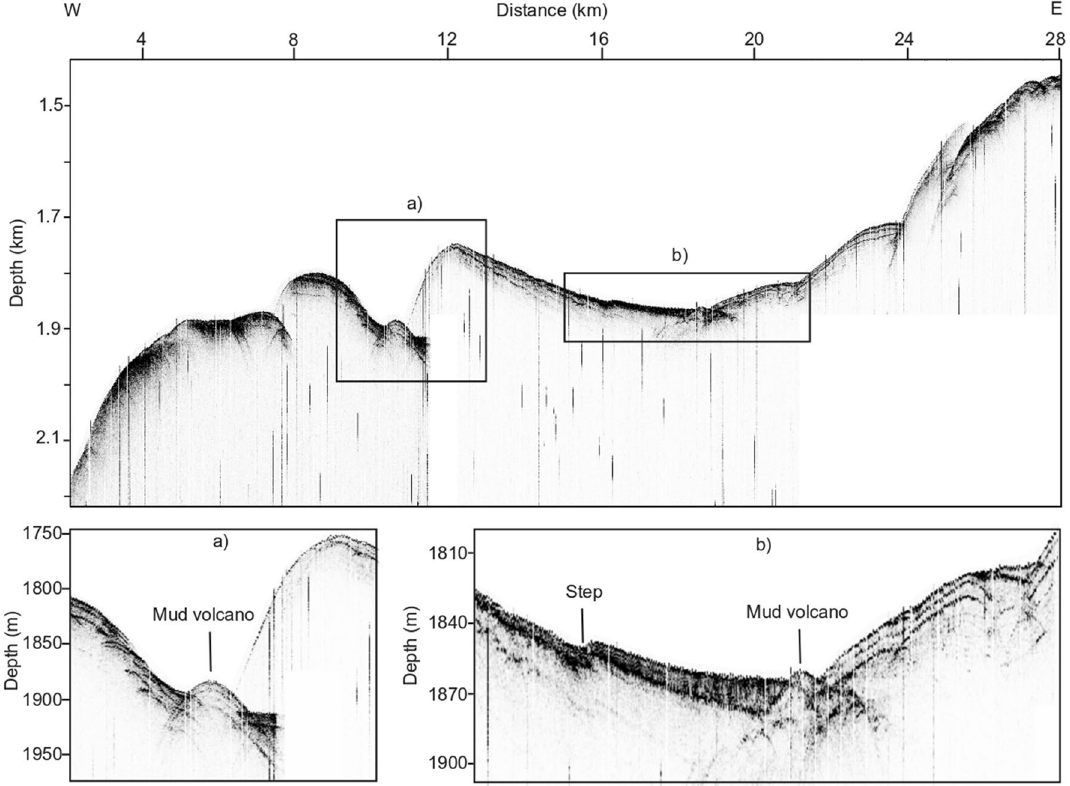
Figure 4. Subbottom profile section. The rectangles in the upper section indicate the position of the zooms ( a , b ), in which mud volcanoes were